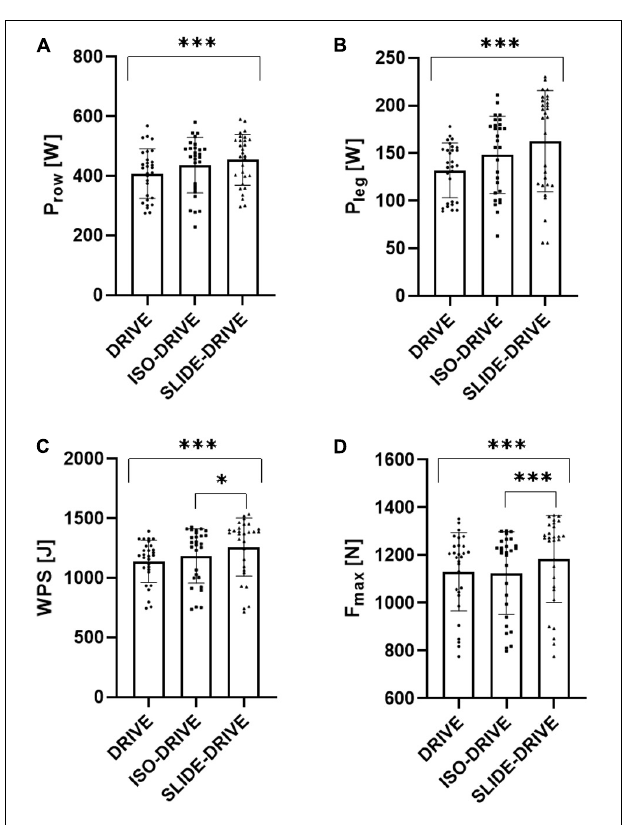
FIGURE 3 | Representation of rowing power (P row , A ), leg power (P leg , B ), work per stroke (WPS, C ), and maximum force (F max , D ) results of the concentric (DRIVE), isometric precontraction (ISO-DRIVE), and FEC type (SLIDE-DRIVE) rowing trials (mean ± standard deviation). In addition, the significances of the post-hoc tests were presented (*** p < 0.001; * p <